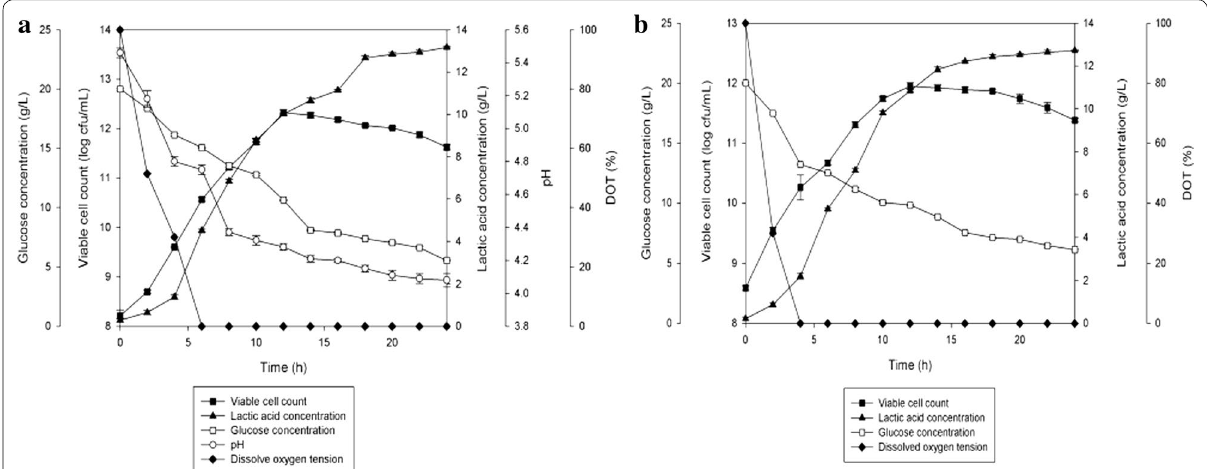
Fig. 2 The time course of batch fermentation of P. acidilactici in 2 L stirred tank bioreactor a without pH control, b with pH control at pH 5.7. The fermentation was conducted at 300 rpm. The error bars represent the standard deviations about the mean (n